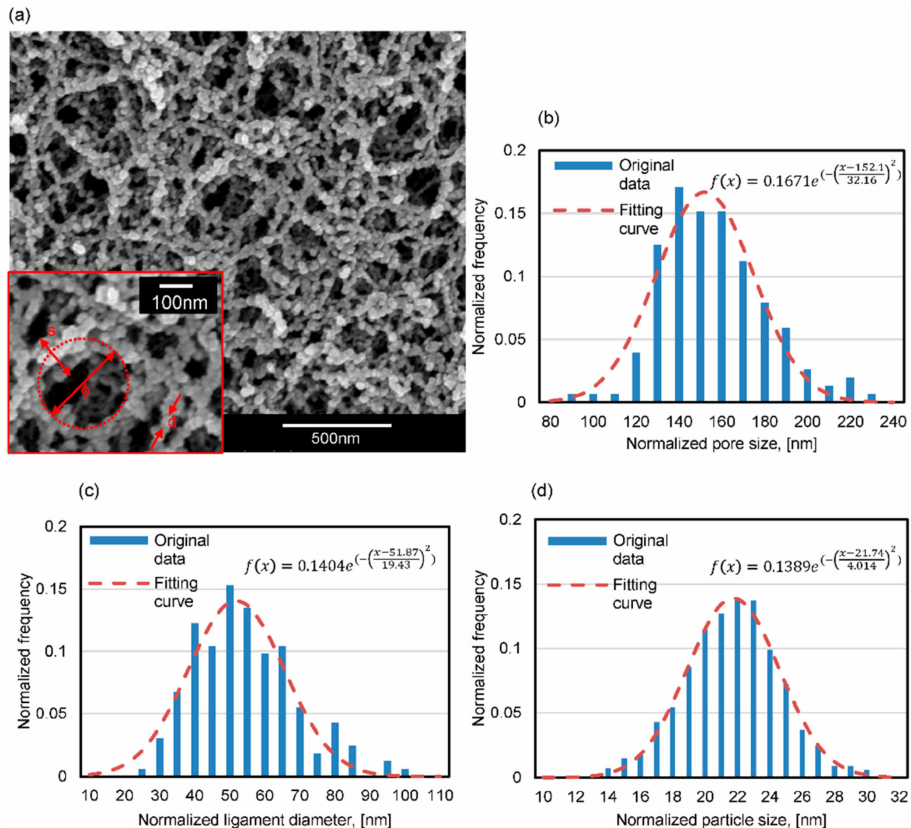
Figure 2. SEM image of the silica aerogel sample with a relative density of 0.098 ( a ), the pore size, ligament diameter and particle size is labelled with φ , s and d , respectively; the histogram of distribution of pore size ( b ); ligament diameter ( c ); and particle size ( d ) of the silica aerogel sample. The red dashed line in each panel represents the fitted Gaussian